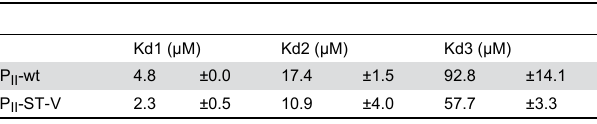
Table 2. Determination of sequential binding of ATP to P wt or P -ST ‑ V II